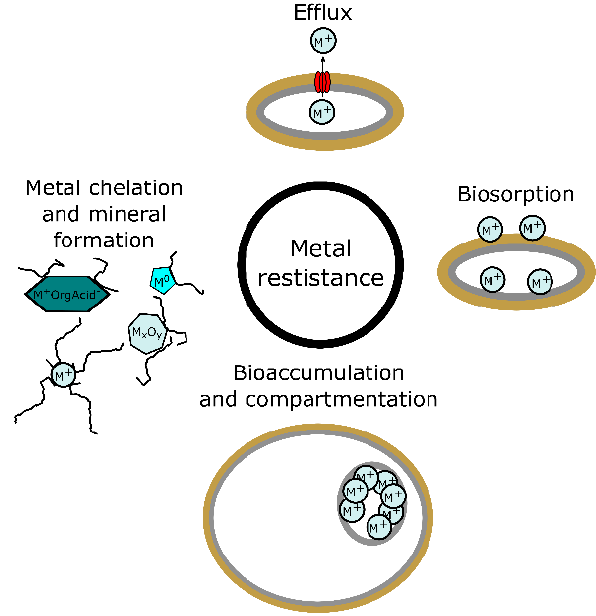
Figure 1. Strategies of metal resistance in fungi.